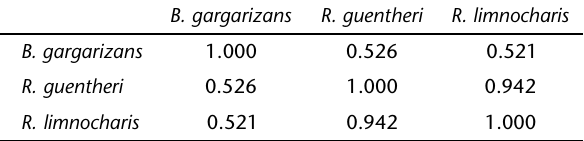
Table II. Morisita-Horn’s food niche overlap (C diagonal) found for Bufo gargarizans , Rana guentheri and Rana limnocharis in Southwest China, calculated from the 20 food items identified in the stomachs of the three species.